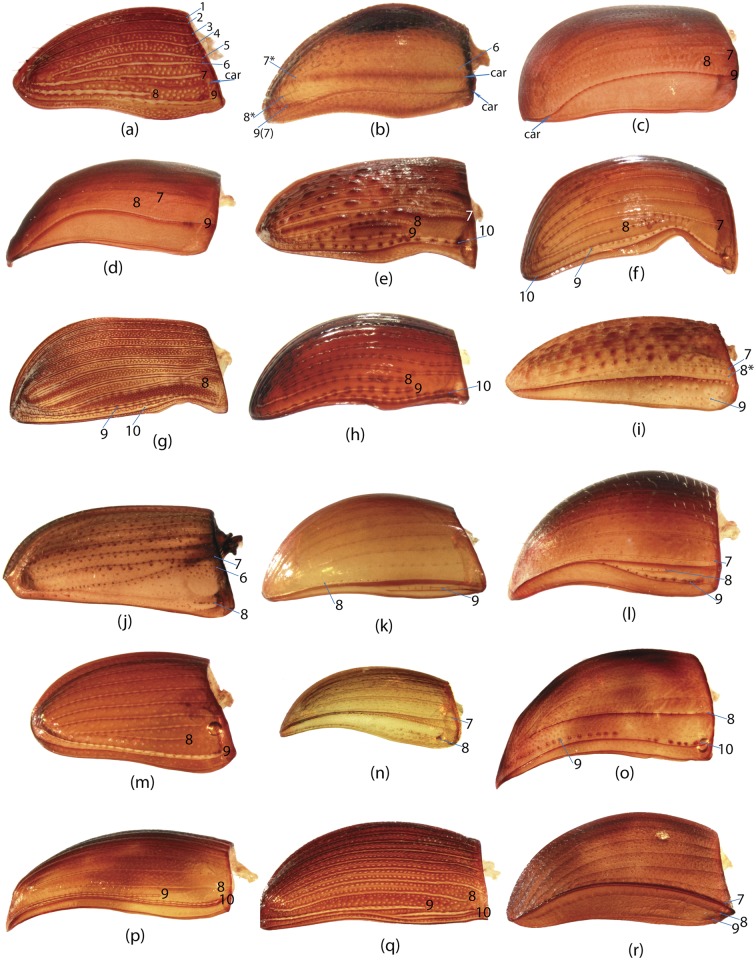
Elytra of Scarabaeinae.a, Odontoloma sp.; b, Endroedyolus paradoxus; c, Dicranocara deschodti; d, Byrrhidium namaquensis; e, Frankenbergerius armatus; f, Delopleurus sp.; g, Sarophorus costatus; h, Paraphytus sp.; i, Epirinus sp.; j, Neosisyphus sp.; k, Janssensantus pauliani; l, Aphengoecus multiserratus; m, Pycnopanelus krikkeni; n, Bohepilissus sp.; o, Macroderes mutilans; p, Xinidium dentilabris; q, Pedaria sp.; r, Gyronotus carinatus; a-r, right elytron, lateral view. Elytral striae are enumerated; indistinct striae or their traces are marked by *.